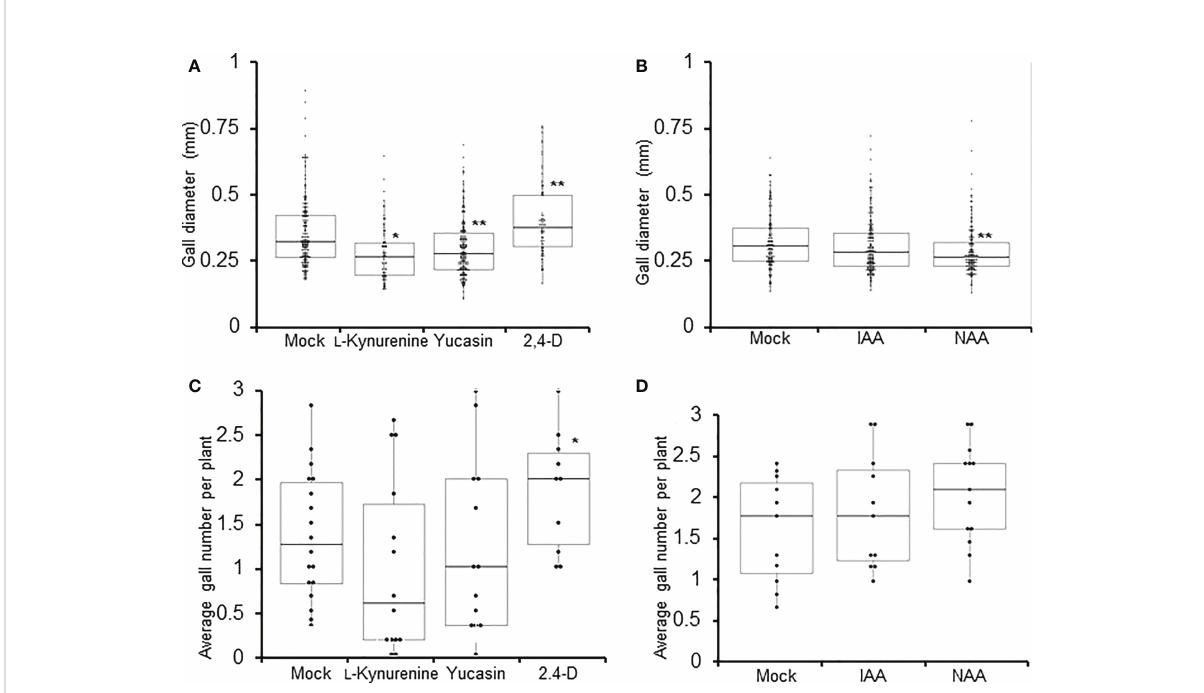
FIGURE 2 Auxin synthesis is required to maintain proper gall size. Gall diameters (A, B) and average gall numbers per plant (C, D) of Arabidopsis seedlings at 7 DPI treated with auxin synthesis inhibitors ( L -kynyurenine, yucasin) or synthetic auxin analogues (2,4-D, IAA, NAA). Boxplots of n ≥ 77 ± SD (A, B) , and boxplots of n ≥ 14 (C, D) are shown. Each data point in (C, D) represents average value from 6 plants. * denotes signi fi cant difference from mock-treated samples, *P<0.05, **P<0.01, generalized Wilcoxon rank sum test corrected for multiple comparisons. At least three biological replicates were performed with similar